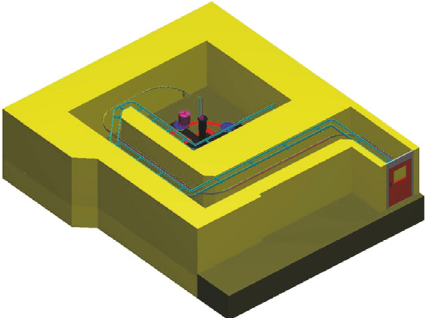
Figure 1: Diagram of the new automatic product loading system for the Gamma Irradiation Laboratory with the opening door of labyrinth.